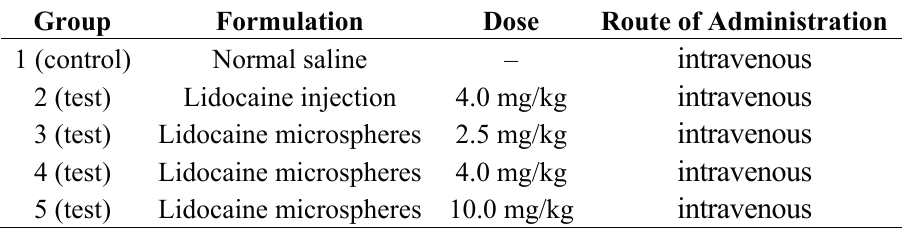
Table 3. The grouping and dosing of lidocaine injection and